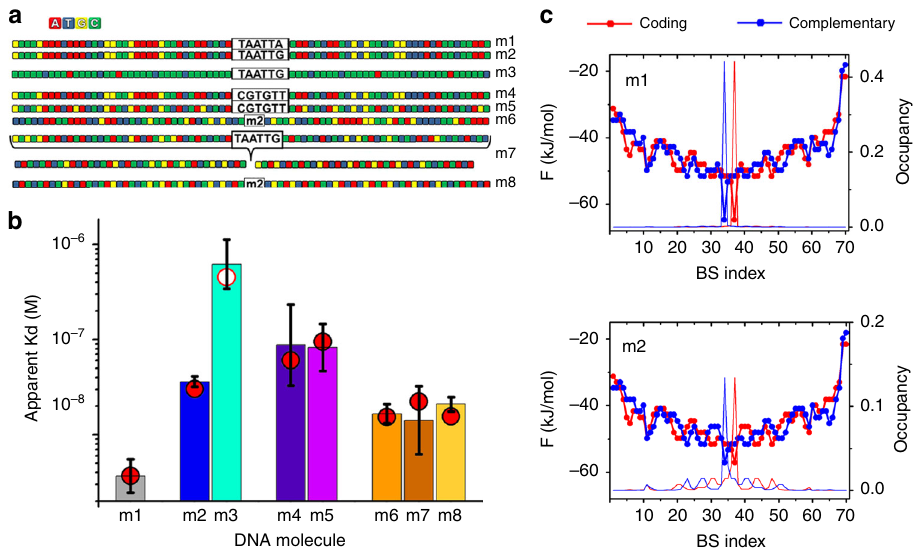
Fig. 4 The region around the speci fi c site produces a rugged free energy landscape. a DNA molecules used to explore the effects of the sequence of the region fl anking the speci fi c site. b Dissociation constants for the DNA molecules shown in panel a obtained by FCS from three independent experiments, and calculated by the statistical mechanical model (red circles). c Examples of binding free energy landscapes and EngHD occupancy pro fi les obtained by the model. BS index indicates the position of the fi rst base of each potential binding site in the coding or complementary strands. The free energy scale is given on the left, and the probability of each site being occupied on the right y -axis. The occupancy pro fi les have been calculated at the same DNA concentration of 10 nM: just above the K D for m1 and below the K D for m2. Bars delimit the 95% con fi dence interval, see Supplementary Table 2. Source data are provided as a Source Data fi